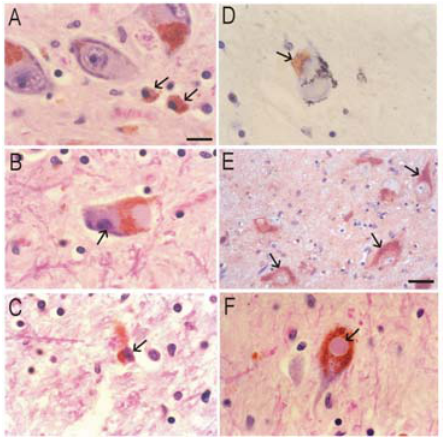
Figure 4. Degeneration of SNc neurons in human PD. A-C. Hematoxylin-eosin (H&E) staining shows that SNc neuron degeneration is characterized by chromatolysis (A), nuclear condensation (B), and severe soma attrition